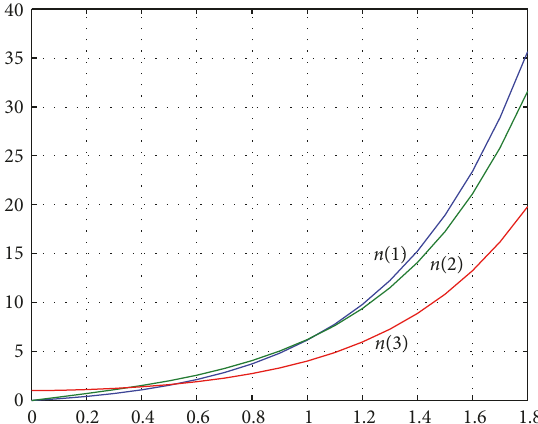
Figure 7: Evolution curve of variables when the initial state set as [1, 0,1] .